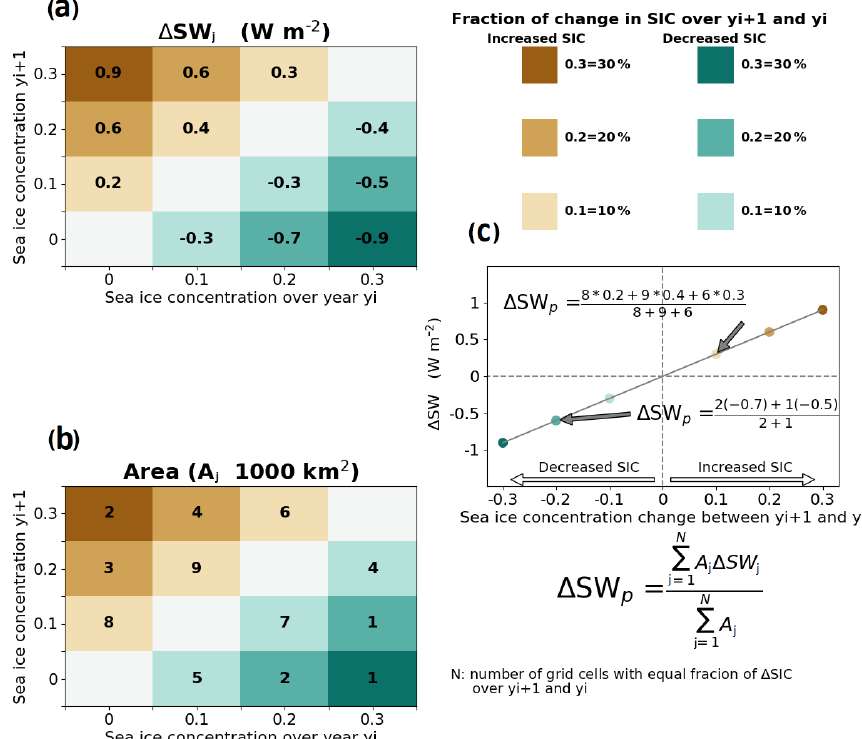
Figure 2. Schematic representation of the methodology used to quantify the energy flux sensitivity to changes in sea ice concentration as a linear regression between the percentage of sea ice concentration and the variation in energy flux (c) using SW energy flux data and sea ice concentration defined in (a, b)